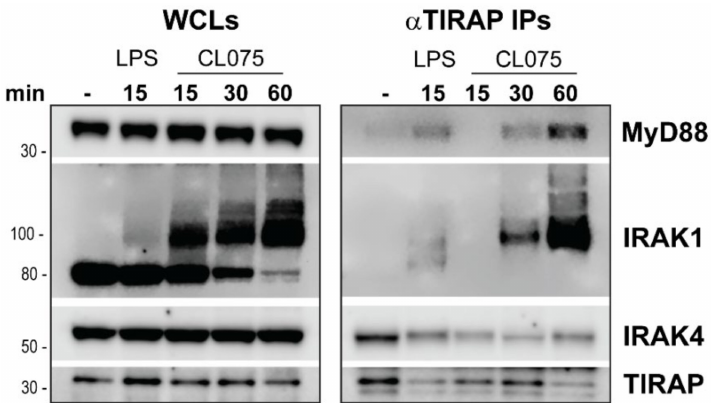
Figure 5. TIRAP is recruited to TLR8-initiated MyD88 and IRAK1/4-signaling complex. Endogenous TIRAP was immunoprecipitated for four hours from lysates (whole cell lysates—WCLs) of human MDMs: untreated or stimulated by LPS (100 ng/mL) or CL075 (2 µ g/mL) for indicated time. LPS stimulation was applied as a positive control for TIRAP recruitment to the activated Myddosome. Cellular lysates were analyzed in parallel to control for input, with WB for MyD88, IRAK1, IRAK4, and TIRAP. A representative experiment is shown from a total of four consecutive experiments with different